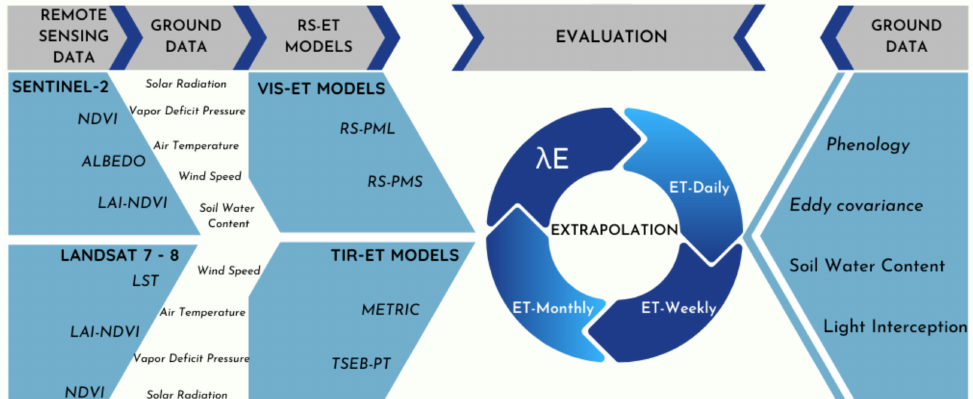
Figure 1. Data sources and their integration with Remote Sensing-based Evapotranspiration (ET) models (RS-ET mod- els). NDVI = Normalized Differential Vegetation Index; LAI - NDVI = Leaf Area Index obtained by NDVI ; LST = Land Surface Temperature; RS-PML: Remote Sensing Penman-Monteith–Leuning Model; RS-PMS = Remote Sensing Penman- Monteith–Stewart Model; METRIC = Mapping EvapoTranspiration with high Resolution and Internalized Calibration; TSEB-PT = Priestley–Taylor Two-Source Model; λ E = Instantaneous Evapotranspiration; ET-Daily = Cumulative Daily Evap- otranspiration; ET-Weekly = Cumulative Weekly Evapotranspiration; ET-Monthly = Cumulative Monthly